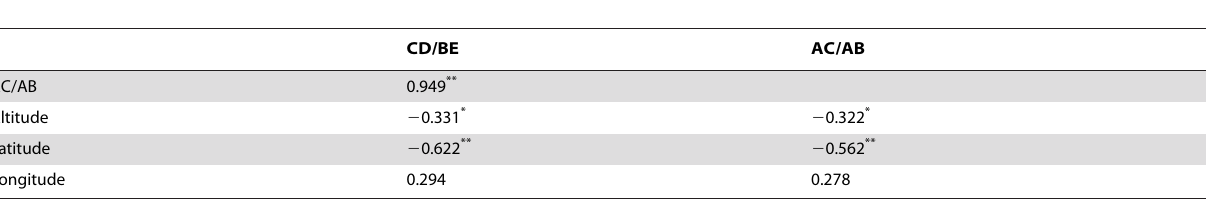
Table 2. Correlation coefficients among the leaf morphological traits and the environmental factors of R. palmatum complex.